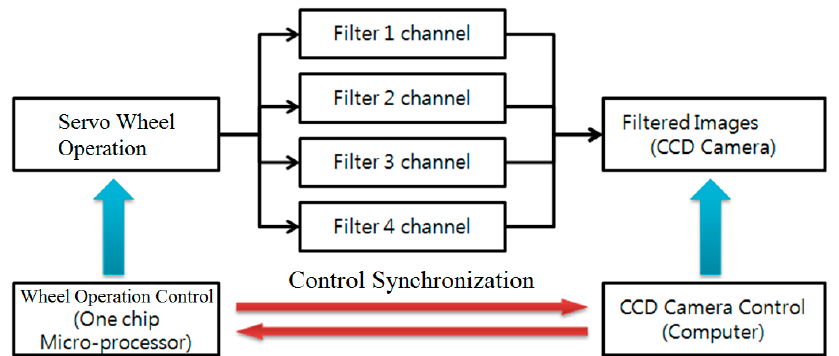
Figure 4. The flow diagram of filter wheel operation and CCD camera control.